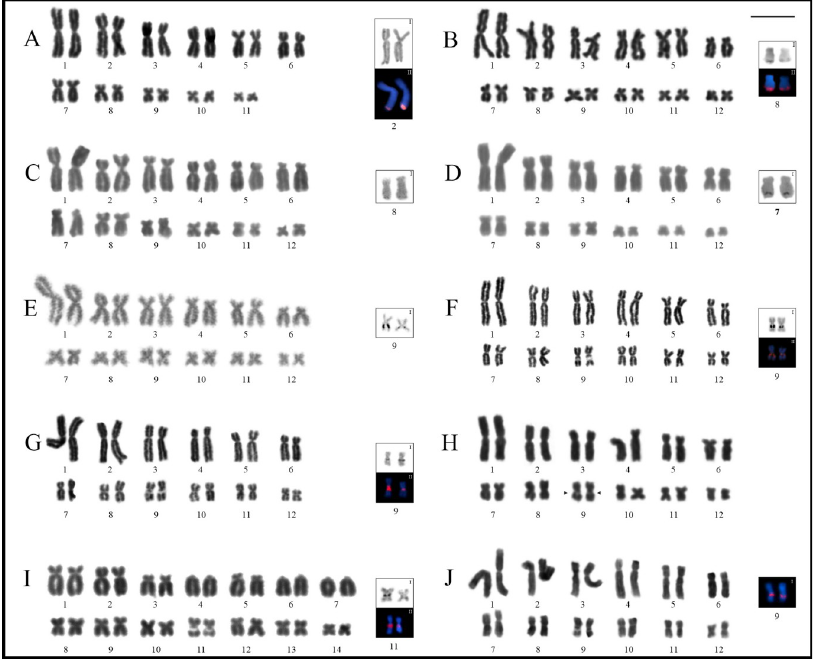
Fig 2. Giemsa stained karyotypes of Phyllodytes and Osteocephalus . A. Phyllodytes edelmoi . B. P . gyrinaethes . C. P . praeceptor . D. P . melanomystax . E. Osteocephalus fuscifacies . F. O . taurinus . G. O . oophagus . H. O . leprieurii . I. O . buckleyi . J. O . planiceps . Squares show chromosomes bearing the NORs after silver staining ( I ) and with FISH using a 18S DNA probe ( II ).